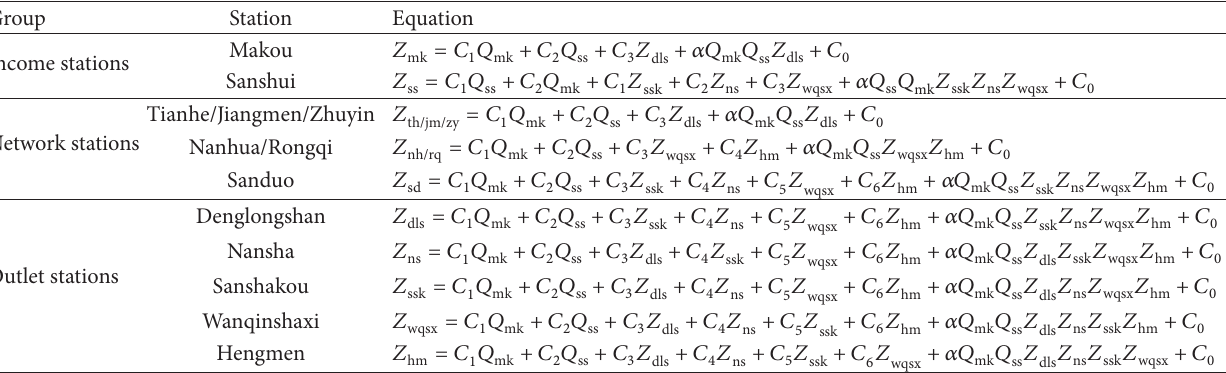
Table 3: Regression model of the PRD